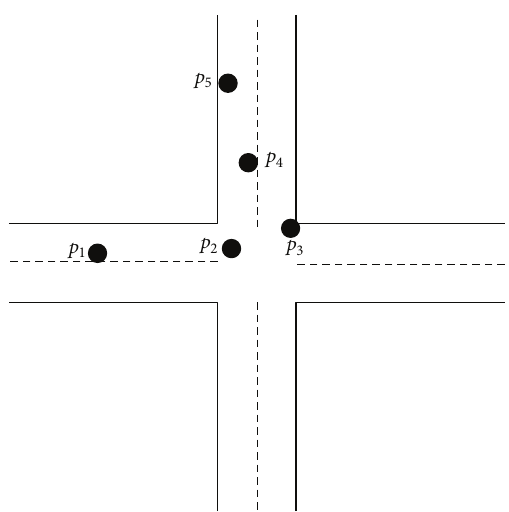
Figure 7: Position errors of GPS/INS points at